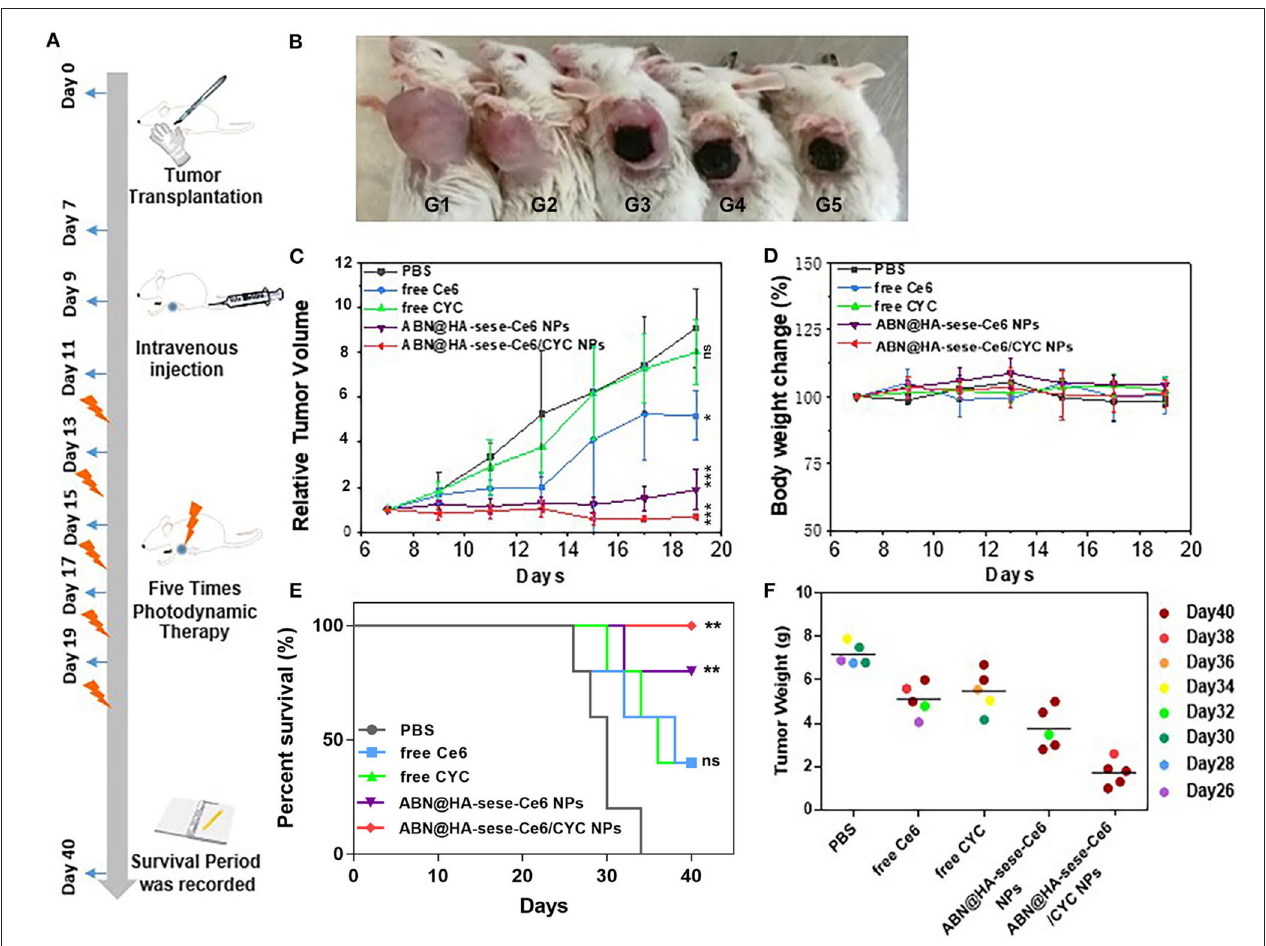
FIGURE 6 | Anti-tumor effects in breast cancer bearing mice model. (A) Schematic illustration of animal experiments. (B) Photos of tumor bearing mice in different treatment group (from left to right: PBS, free CYC, free Ce6, ABN@HA-sese-Ce6 NPs, ABN@HA-sese-Ce6/CYC NPs treatment group). (C) Tumor volume curve of mice treated with PBS, free Ce6, free CYC, ABN@HA-sese-Ce6 NPs, ABN@HA-sese-Ce6/CYC NPs ( n = 5). The data are mean ± SD, * p < 0.05, ** < 0.01, *** < 0.001 vs. PBS group. (D) Body weight change curve of mice in above groups. (E) The survival curve of mice in different groups. * p < 0.05, ** < 0.01, *** < 0.001 vs. PBS group ( n = 5). (F) Excised tumor weight of mice in above treatment groups when natural death or on Day 40 (endpoint).